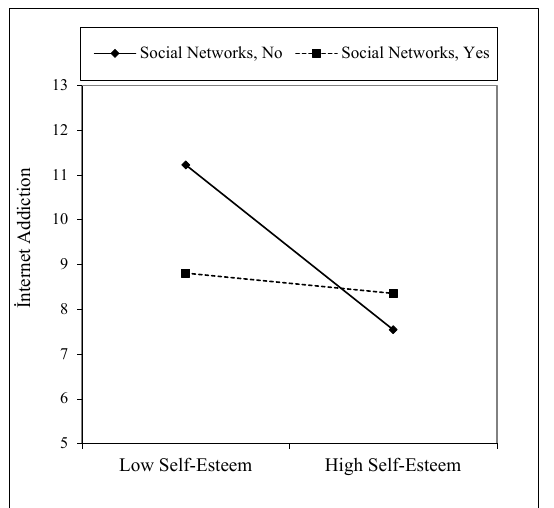
Figure 4. Interaction effect of self-esteem and social networks on internet addiction.